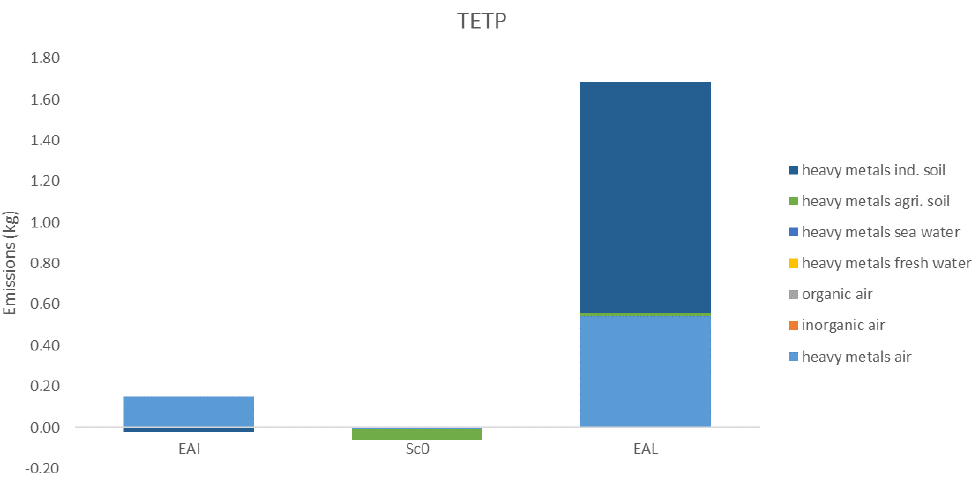
Figure 10. Terrestric ecotoxicity comparison for the reference case (Sc0) among average European scenarios. Results refer to one tonne of treated residues.